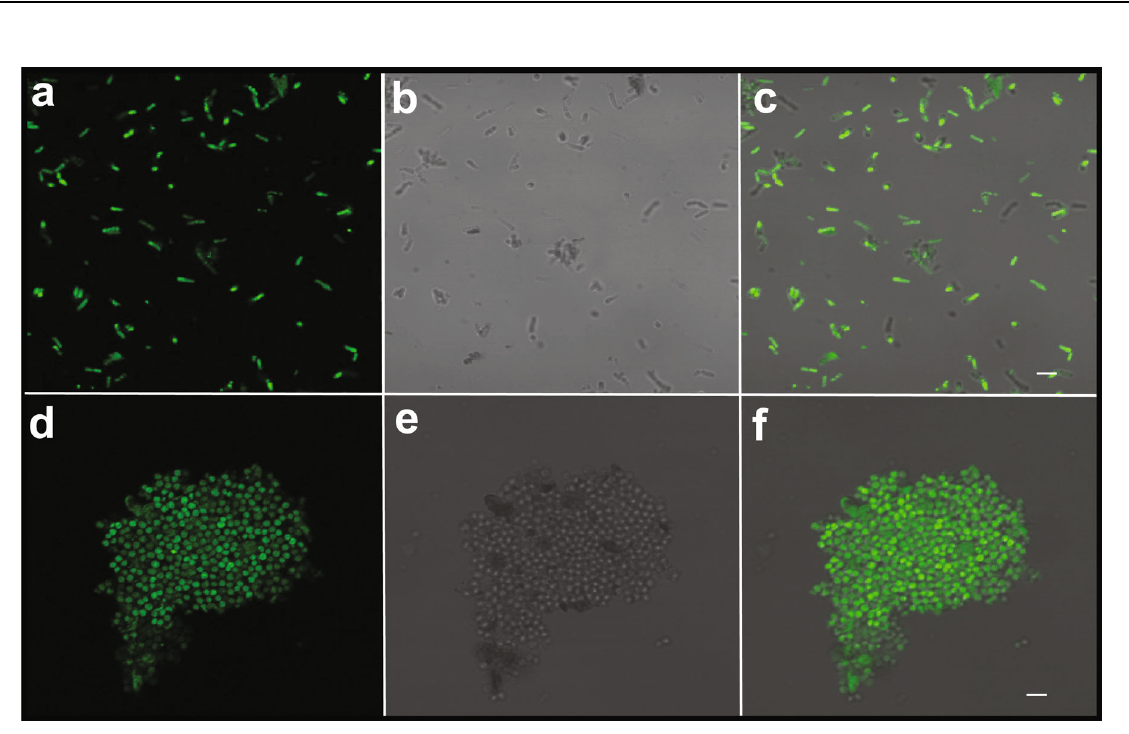
Fig. 3 Confocal images of cells incubated with FITC-HSEP2 at 2X MIC. Confocal images of B. cereus : a Fluorescence image, b DIC image, and c merged image. Confocal images of M. luteus : d Fluorescence image, e DIC image, and f merged image. For fi gures a – c , scale bar